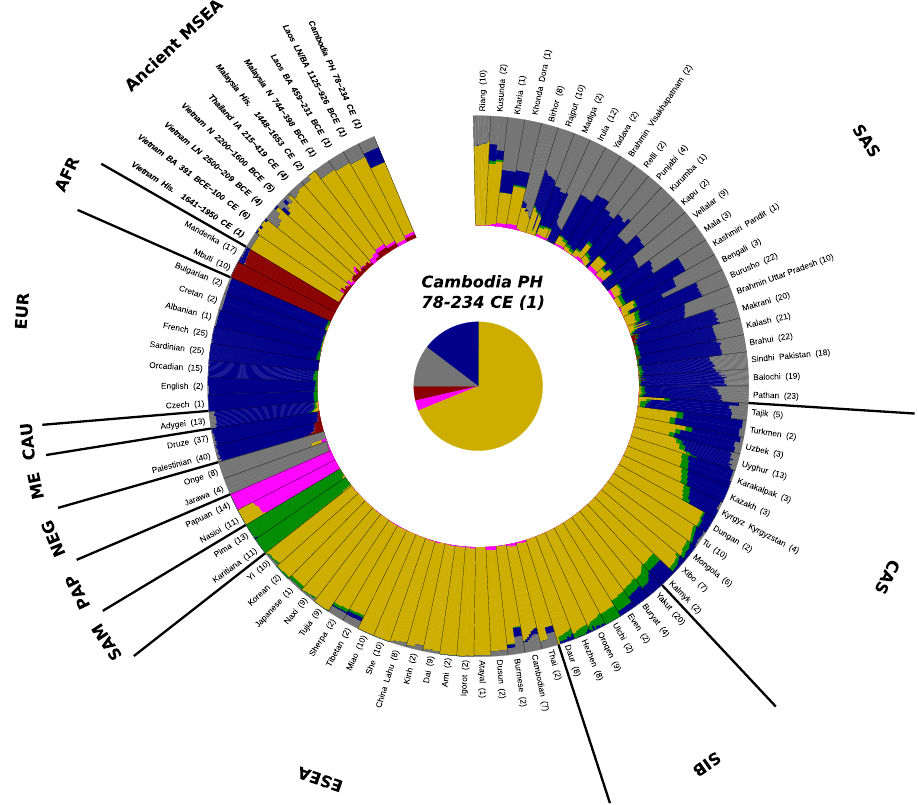
Figure 3. An ADMIXTURE analysis plot showing results for 6 hypothetical ancestral groups ( K = 6). Abbreviations for meta-populations are as follows: Ancient MSEA Ancient Mainland Southeast Asians, AFR present-day Africans, EUR present-day Europeans, CAU present-day Caucasians, ME present-day Middle Easterners, NEG present-day Andamanese Negritos, PAP present-day Papuans, SAM present-day Native Meso- and South Americans, ESEA present-day East and Southeast Asians, SIB present-day Siberians, CAS present-day Central Asians, SAS present-day South Asians, N Neolithic, LN Late Neolithic, PH Protohistoric period, BA bronze age, His. Historical period. The number of individuals for each population is indicated in brackets after the population name.